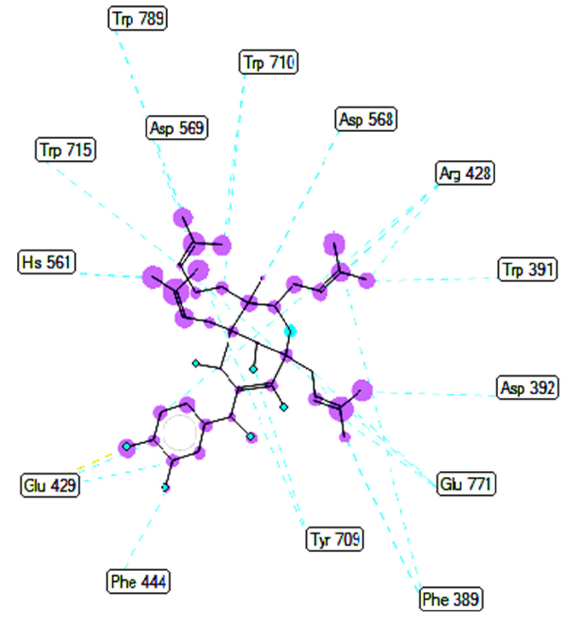
Figure 9. Ligand map showing the secondary interactions such as hydrogen bonding and steric and overlap interactions between residual amino acids on enzyme 4J5T and pose 41/200, compound 2 .